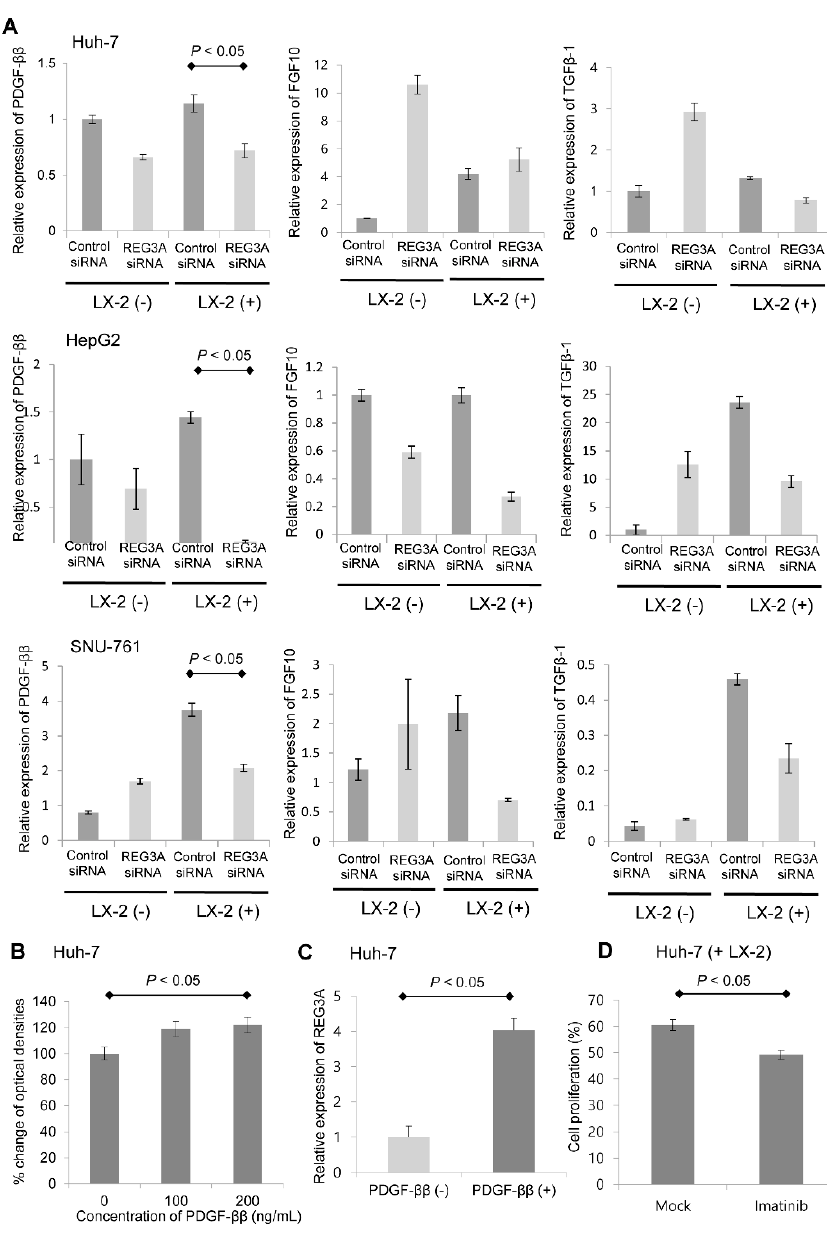
Figure 5. REG3A enhanced HCC proliferation by reciprocally influencing PDGF- ββ . ( A ) REG3A siRNA significantly decreased the mRNA expression of PDGF- ββ in cocultured HCC cells ( p < 0.05). The experiment was repeated three times. The data are expressed as mean ± SD. ( B ) Exogenous PDGF- ββ (200 ng / mL) enhanced the proliferation of HCC cells based on the MTT assay results ( p < 0.05). The experiment was repeated three times. The data are expressed as mean ± SD. ( C ) Exogenous PDGF- ββ enhanced the expression of REG3A in cocultured HCC cells. The experiment was repeated three times. The data are expressed as mean ± SD. ( D ) Huh-7 cells were treated with PDGF receptor inhibitor (imatinib, 10 µ M) under coculturing with LX-2. After 24 h, an MTT assay revealed that imatinib significantly suppressed the proliferation of Huh-7 cells ( p < 0.05). Data are expressed as mean ± SD of percent changes of triplicate optical densities compared to that of control.